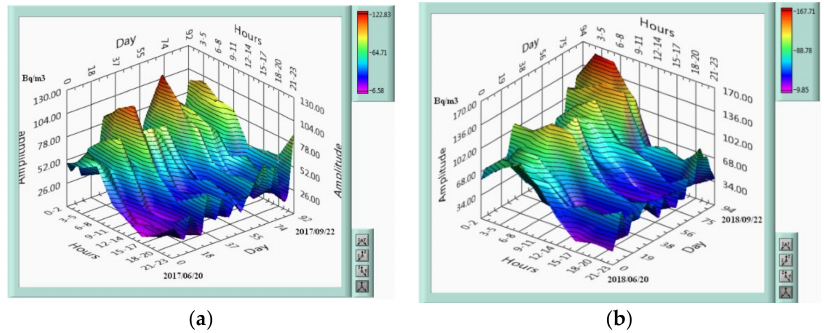
Figure 5. Radon evolution in Bisoca station, summer: ( a ) 2017; ( b )